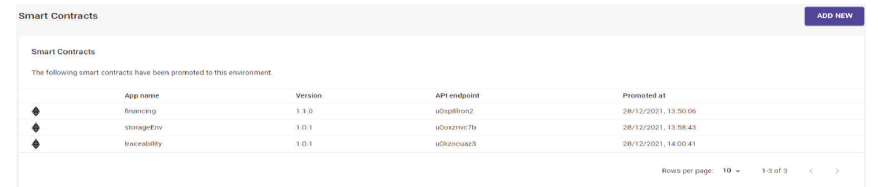
Figure 9: The blockchain includes smart contracts.